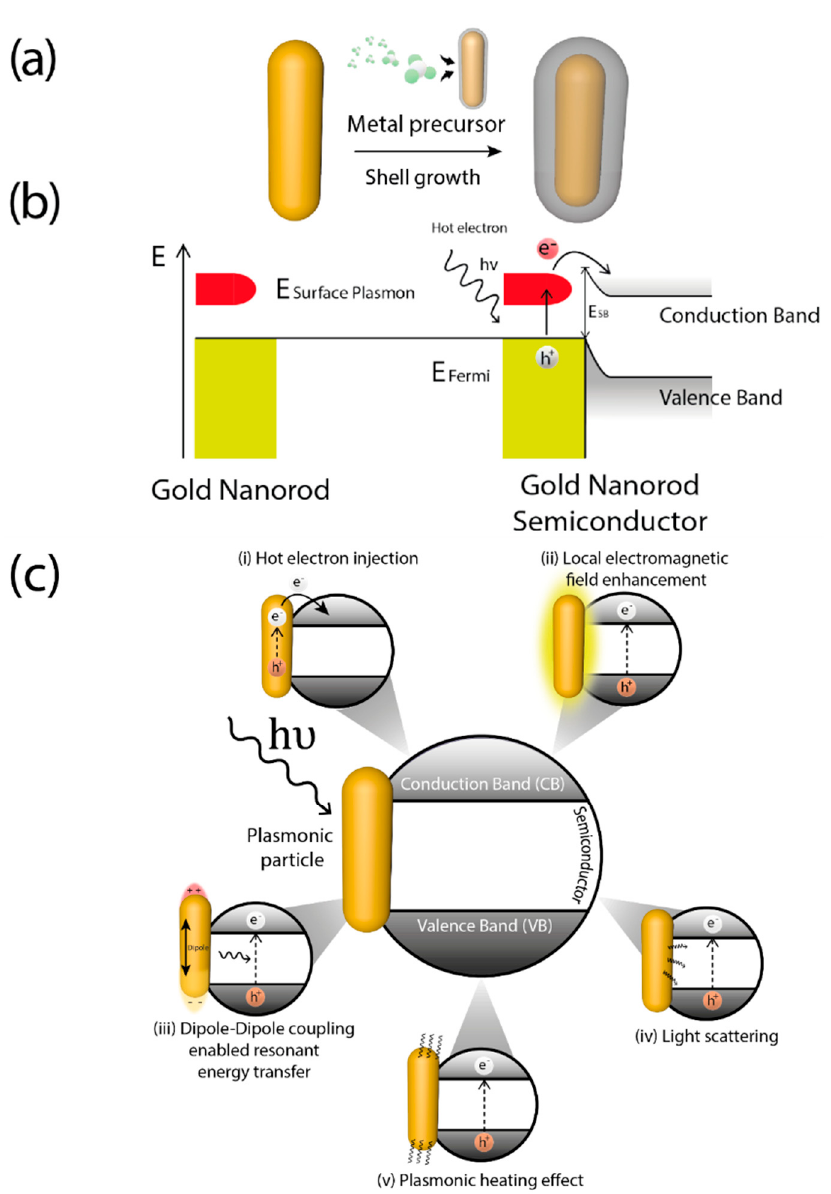
Figure 2. ( a ) Formation of Au-semiconductor heterostructures for the particular case of a core-shell structure. Different wet chemistry approaches are available to create a wide range of morphologies; ( b ) hot electron injection process. When a plasmonic structure as, in example, AuNR is irradiated with light with an energy equal to its LSPR, electrons mainly coming from conduction band are excited. If their energy overcomes the Schottky barrier energy (E SB ), they can be injected into the semiconductor conduction band to further perform the photocatalytic process; ( c ) mechanisms involved in plasmonic-semiconductor heterostructures (adapted from [46]). Diverse physical processes may take place between plasmonic nanostructure and semiconductor to promote valence band electrons to conduction band energy